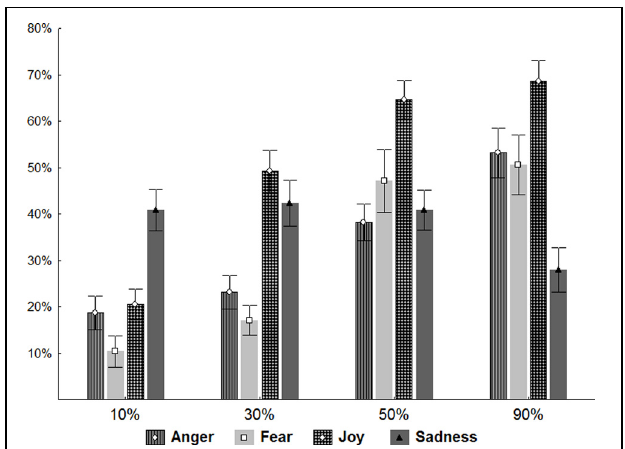
FIGURE 2 | Static Images. Plots show the results of the mixed-design ANOVA performed on the correct answers given by the subjects of both groups of participants. The correct answers are expressed in percentage: 10, 30, 50, and 90% indicate the four levels of intensity of emotion